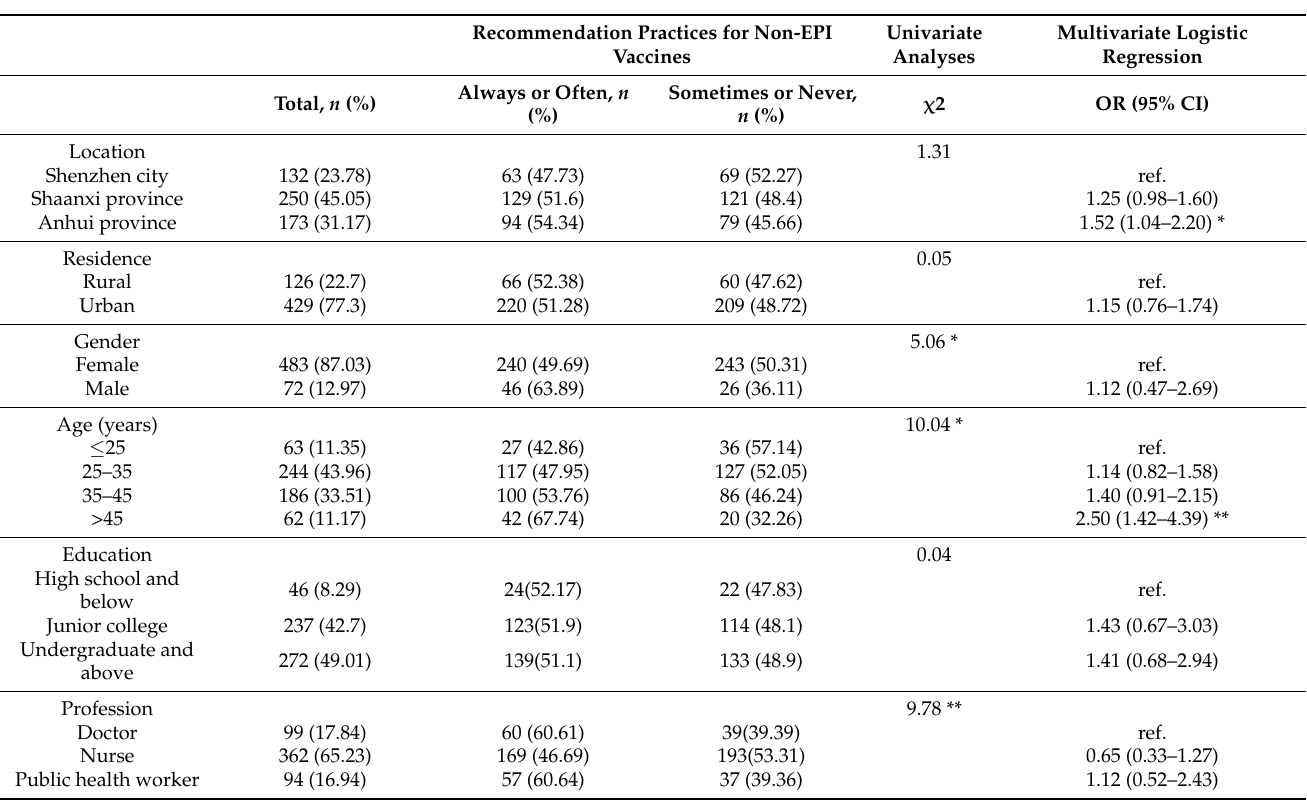
Table 1. Recommendation for non-EPI vaccines and its associated factors among vaccination service providers participating in the